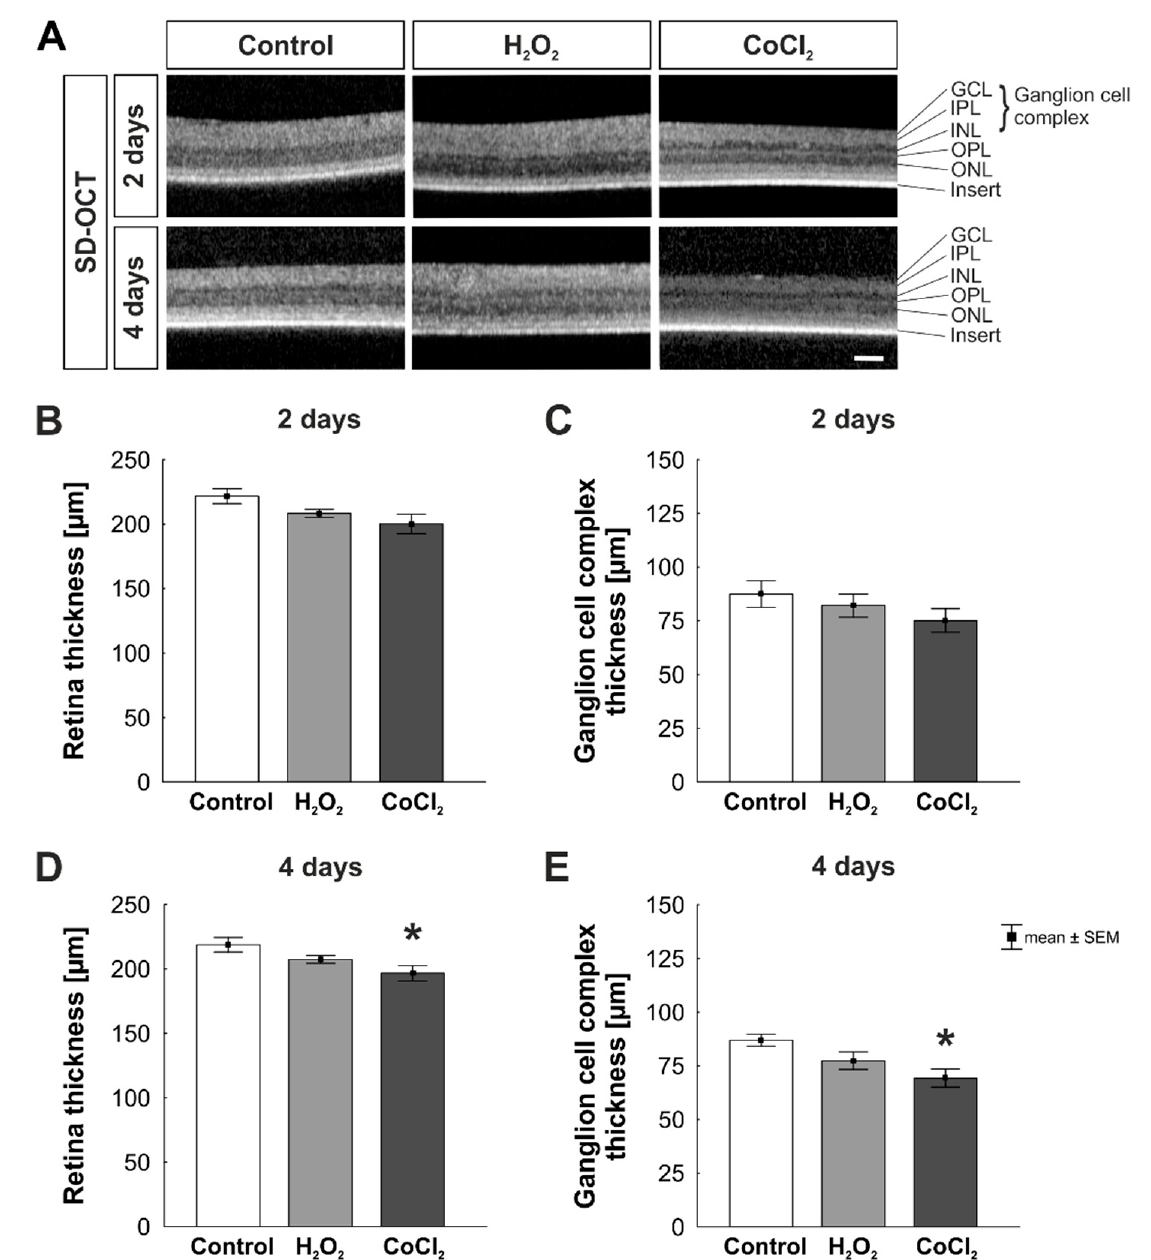
Figure 2. Loss of retinal thickness caused by hypoxia. ( A ) Exemplary SD-OCT-images of retinas cultivated for two and four days. ( B ) Total retinal thickness was not affected by oxidative stress nor hypoxia after two days. ( C ) The thickness of the ganglion cell complex (GCL + IPL + INL) was not altered in any of the groups after two days. ( D ) A significantly thinner retina thickness was noted in hypoxia-stressed retinas at four days ( p = 0.024). ( E ) Also, the ganglion cell complex of hypoxia stressed retinas was significantly thinner than control retinas ( p = 0.015). GCL = ganglion cell layer; IPL = inner plexiform layer; INL = inner nuclear layer; OPL = outer plexiform layer; ONL = outer nuclear layer. N = 5–6. Scale bar: 100 µ m. Values are shown as mean ± SEM. Columns marked with * show significant differences in comparison to the control group. * p < 0.05.